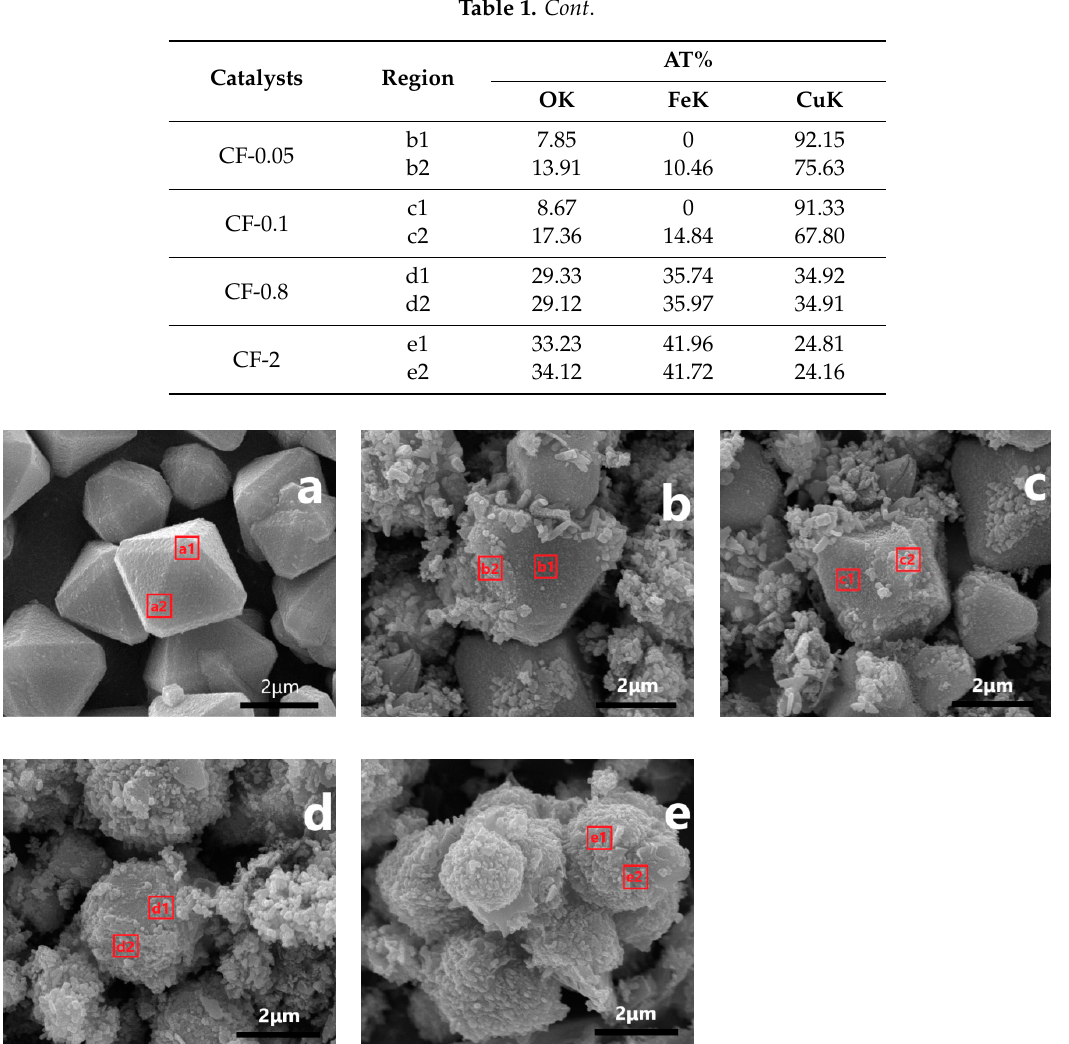
Figure 4. SEM images of Cu 2 O and Cu x O-Fe y O z with different Fe/Cu ratios ( a ) Cu 2 O, ( b ) CF-0.05, ( c ) CF-0.1, ( d ) CF-0.8, and ( e ) CF-2. Table 1. EDS element analysis of different regions.